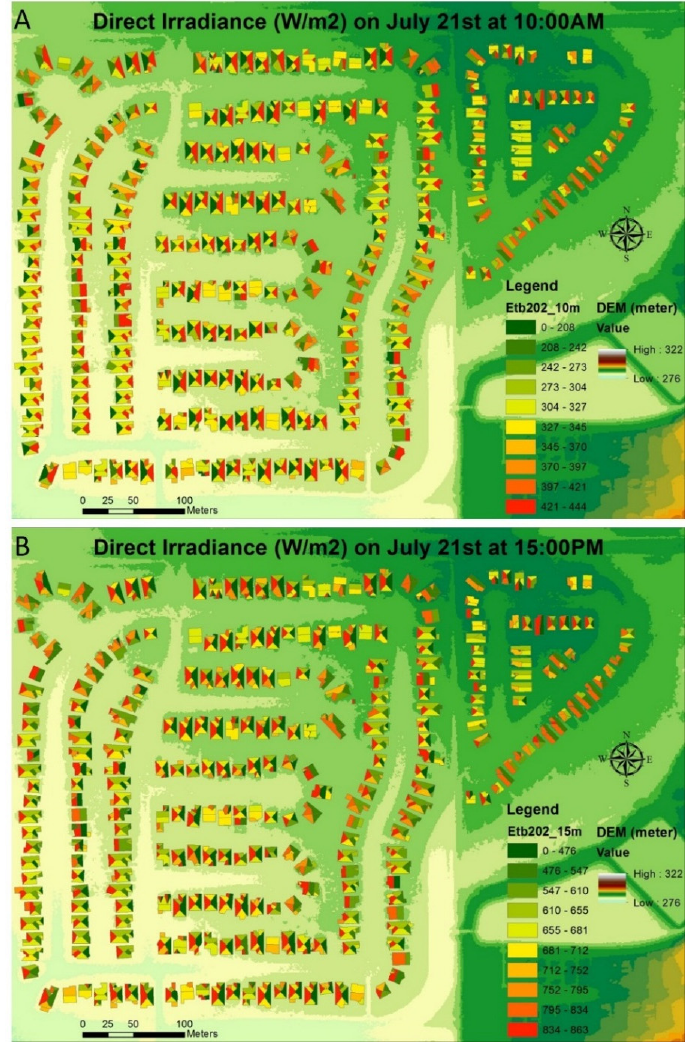
Figure 7. LiDAR-based solar map of a neighborhood in San Antonio on 21 July at 10:00 a.m. ( A ) 15:00 p.m. ( B ).